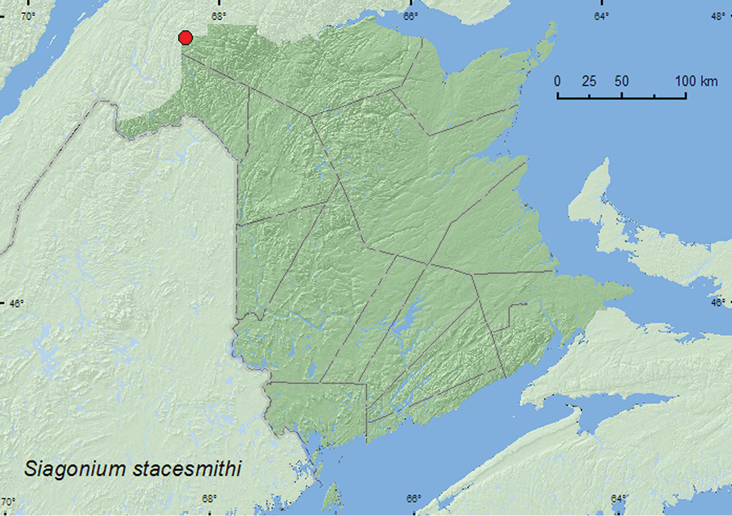
Collection localities in New Brunswick, Canada of Siagonium stacesmithi.